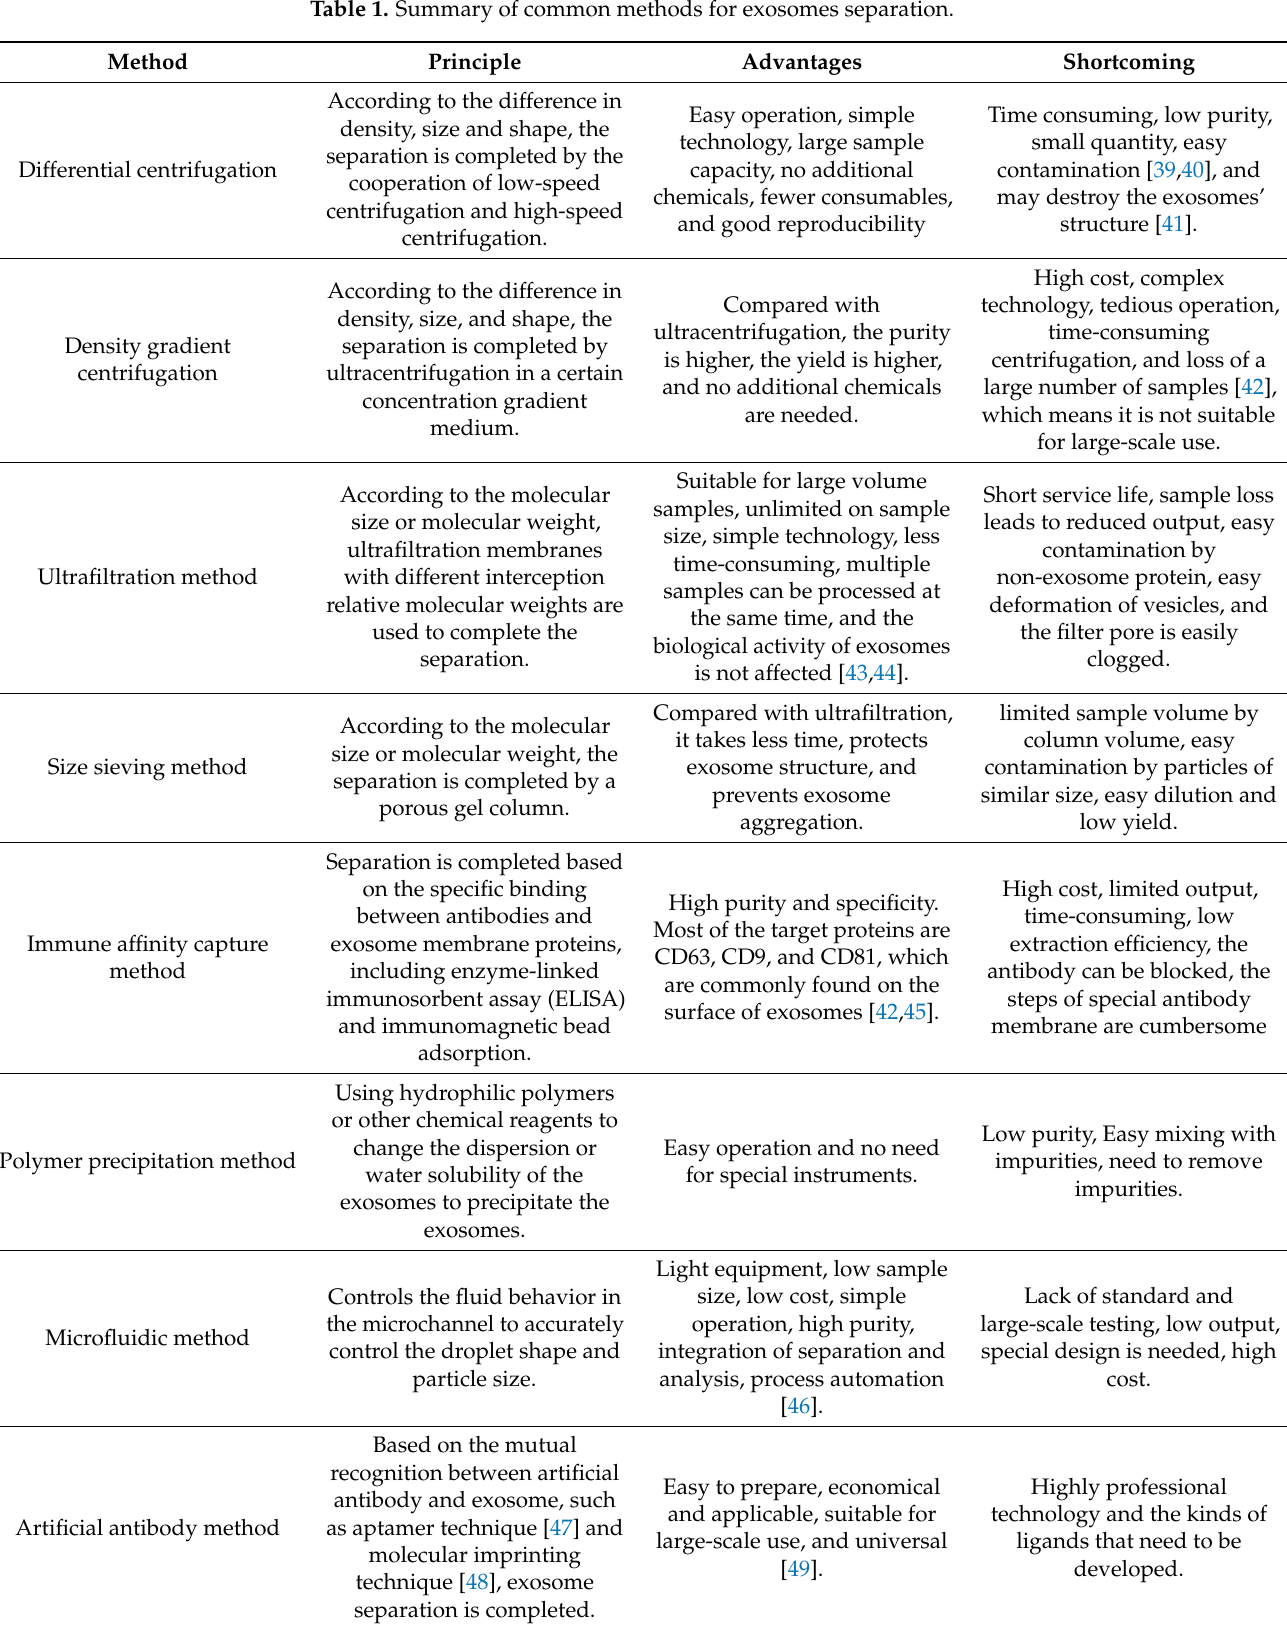
Table 1. Summary of common methods for exosomes